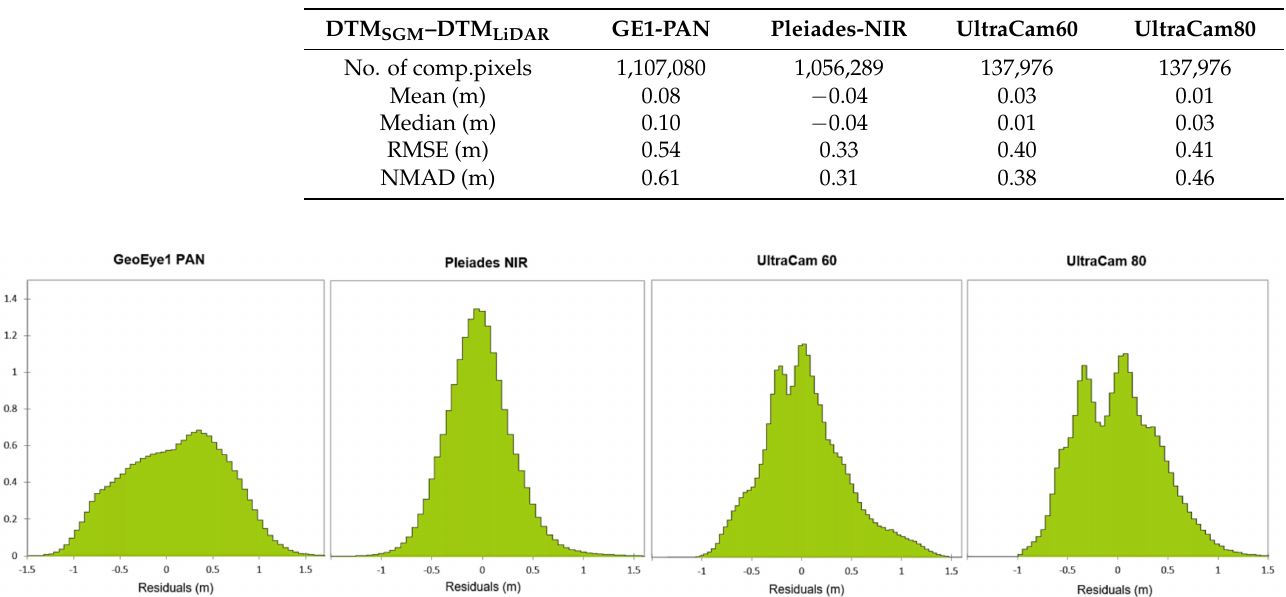
Figure 5. Error distribution histograms of ground surface pixel-wise comparison of the corresponding image-based (DTM SGM ) and LiDAR (DTM LiDAR )